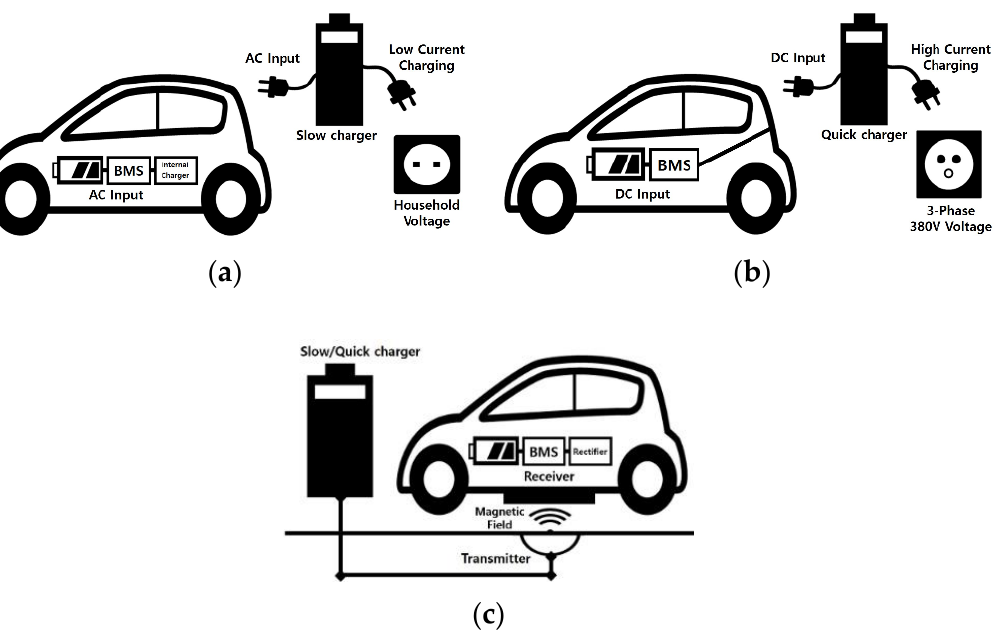
Figure 1. Electric vehicle charging method. ( a ) Slow wired charging. ( b ) Quick wired charging. ( c ) Wireless power transfer (WPT) charging.